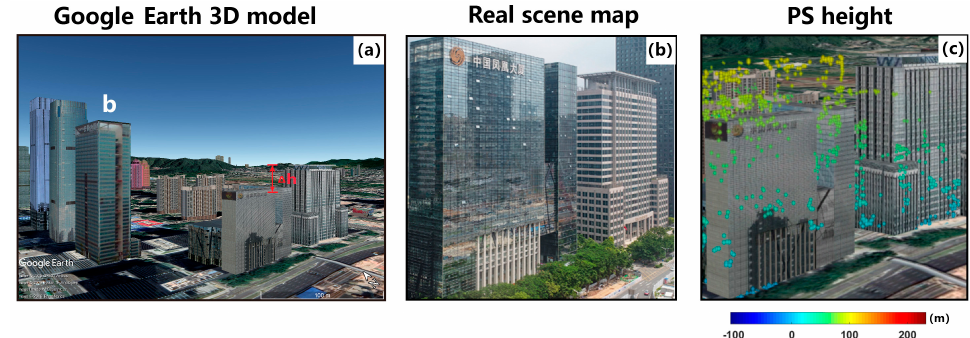
Figure 7. ( a ) The Google Earth 3D model of the FengHuang building in Figure 6 and ( b ) its real scene map; ( c ) the three-dimensional representations of the extracted PS point heights geocoded in the Google Earth 3D model.